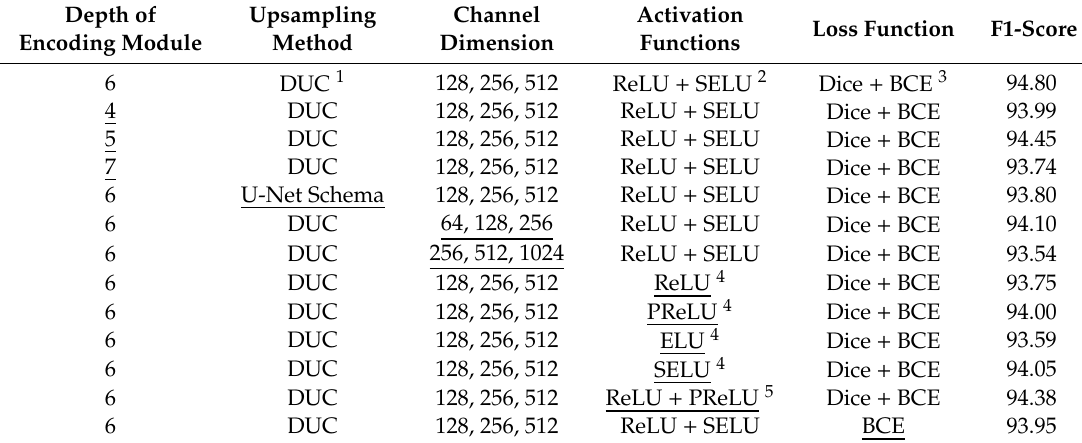
Table 5. DE-Net self-comparison study results on the testing set of the WHU dataset in terms of F1-Score (%) (the di ff erent component from the baseline model are